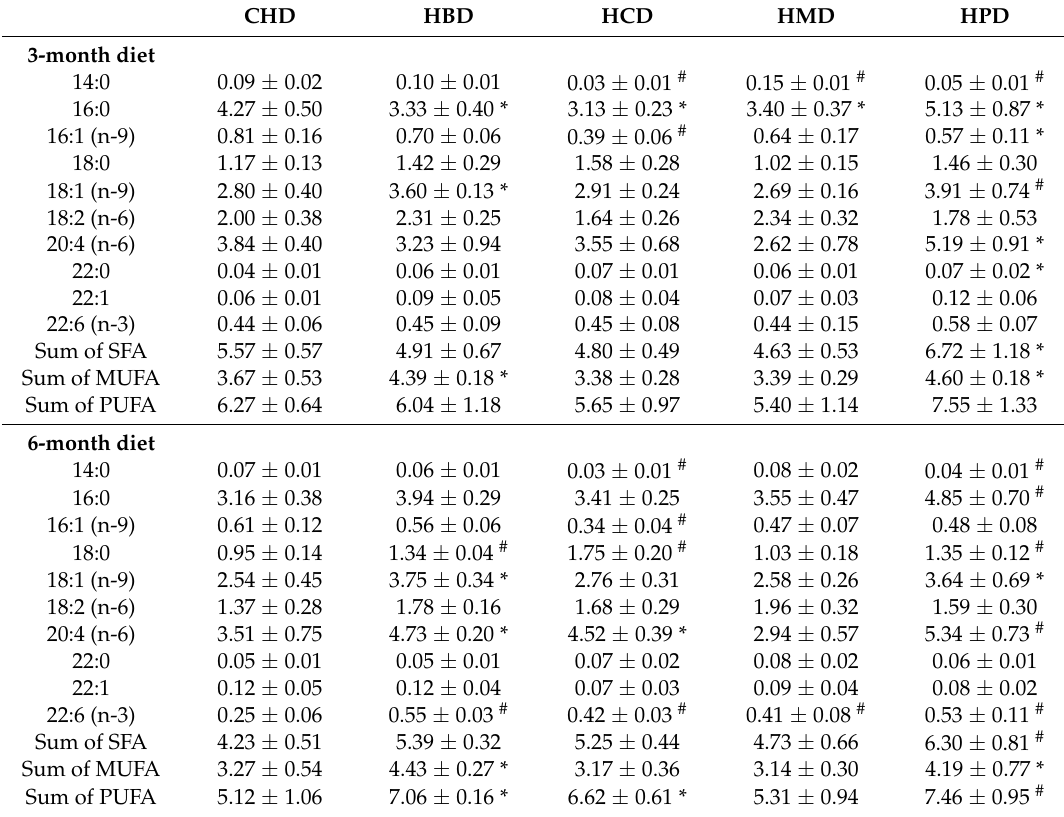
Table 1. Fatty acid composition of total lipids in serum of mice fed different high-fat diets 1